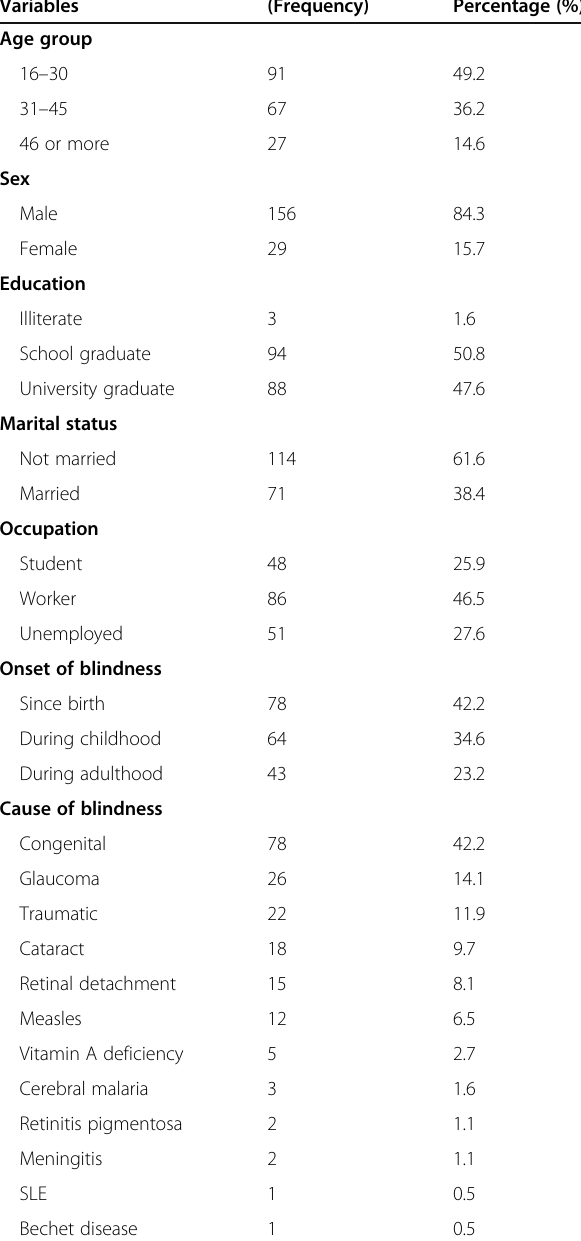
Table 1 Socio-demographic characteristics of the participants Variables